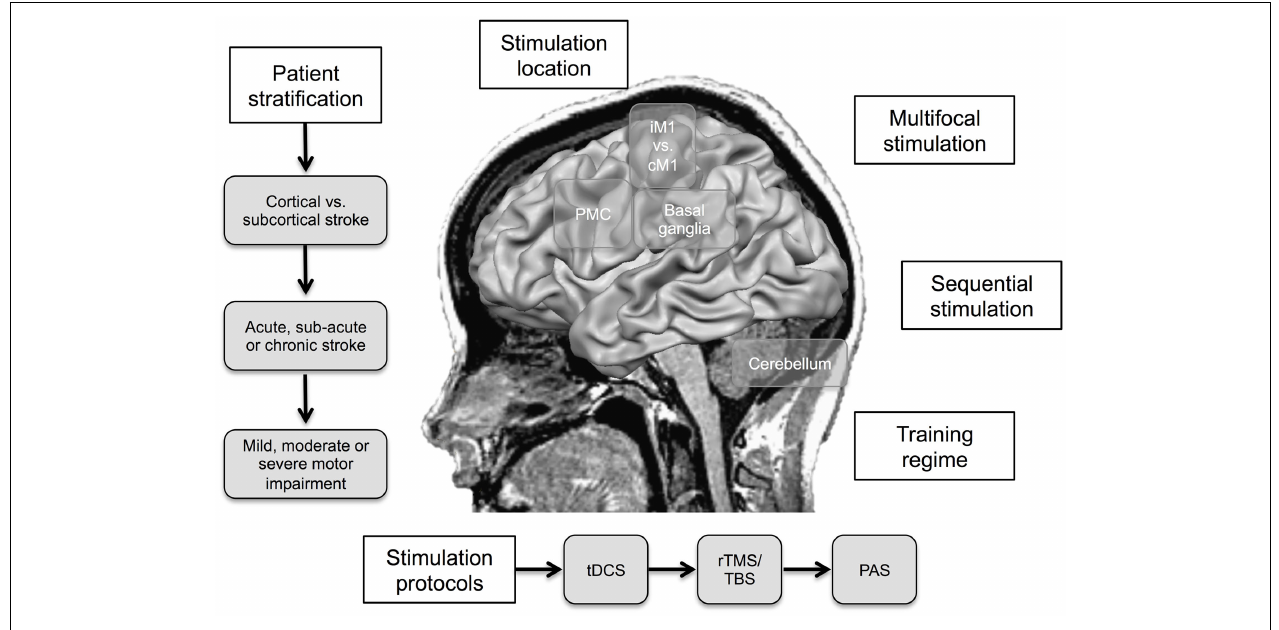
premotor cortex; tDCS, transcranial direct current stimulation; rTMS, repetitive transcranial magnetic stimulation; TBS, theta-burst stimulation; PAS, paired associative stimulation.